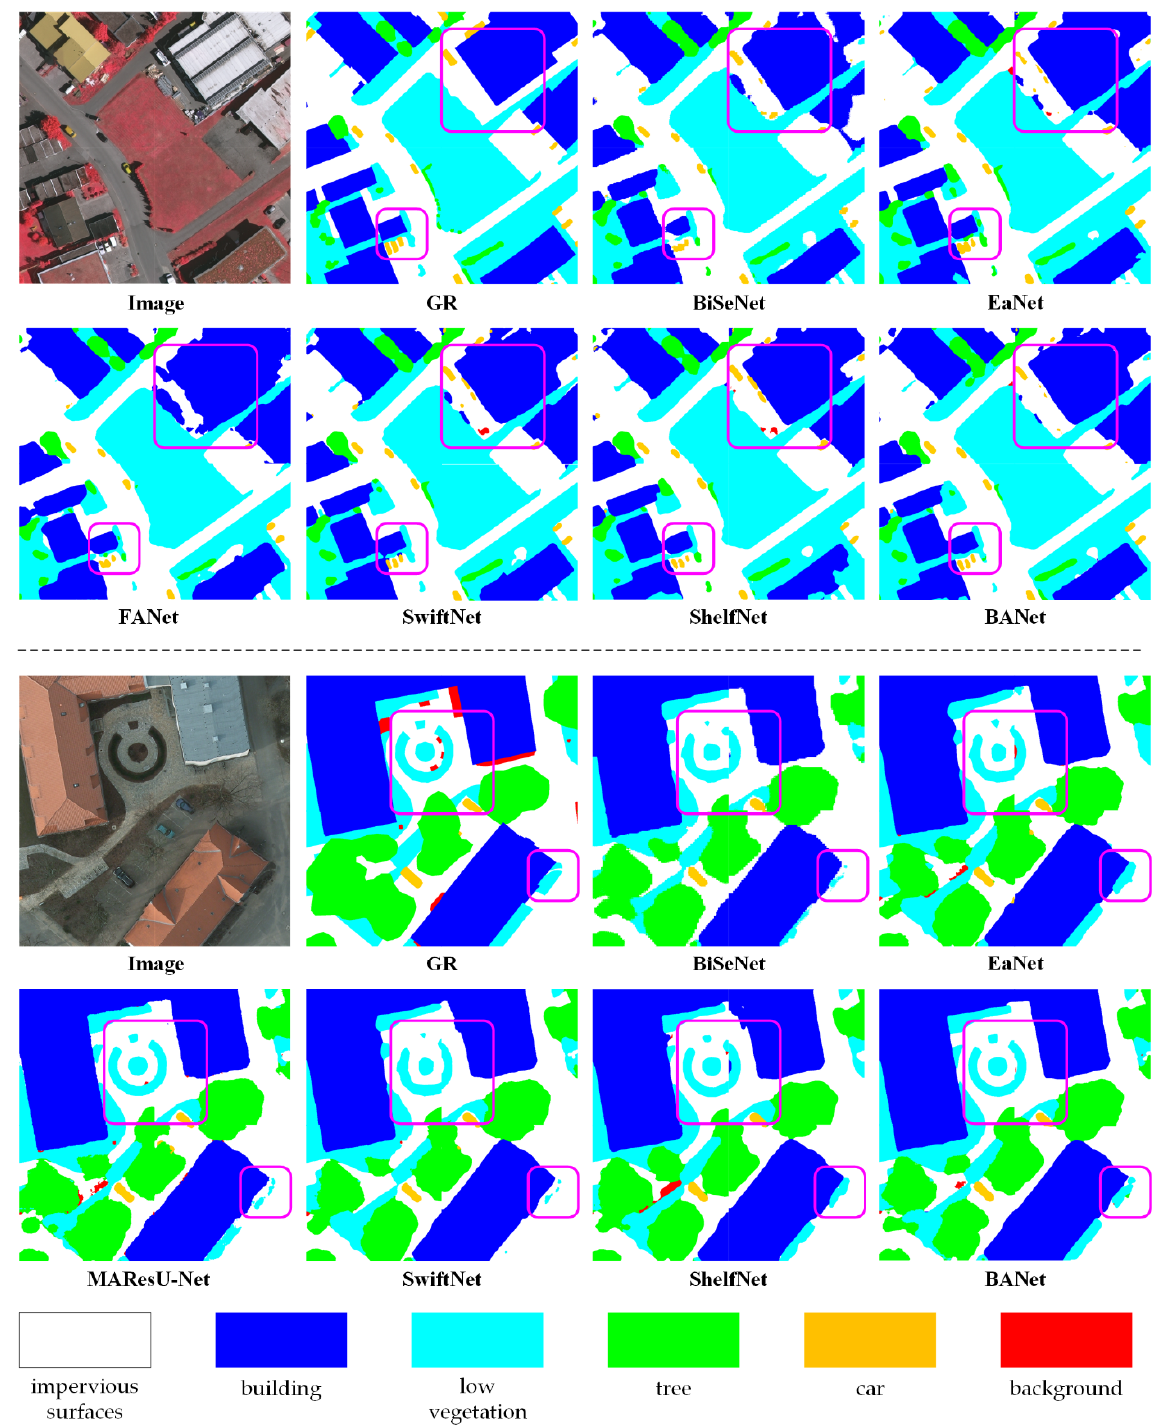
Figure 8. The experimental results on the ISPRS Vaihingen dataset ( top part) and Potsdam dataset ( bottom part). GR represents Ground Reference.